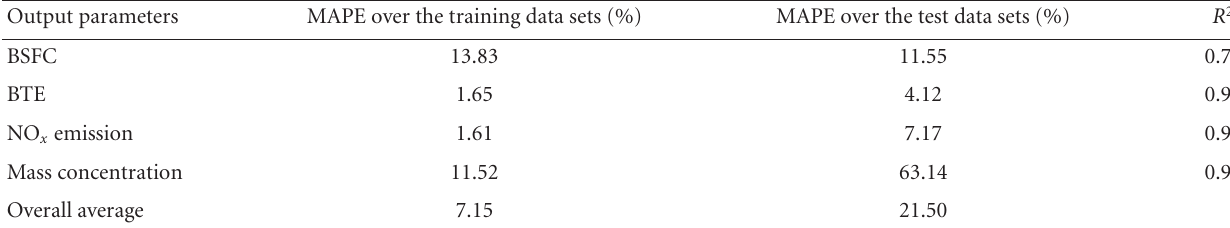
Table 4: Results of the RVM models.